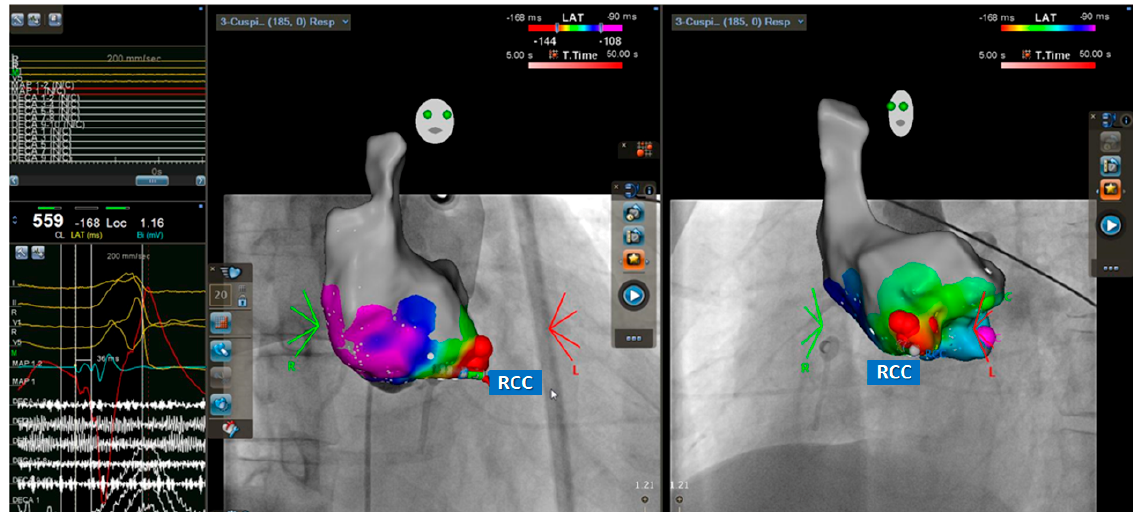
Figure 2. Activation map and fluoroscopic map for ventricular premature complex originating from the right coronary cusp (RCC). The local activation map showed the earliest activation site ( − 36 ms) at the RCC and catheter ablation in this area (red spots) could eliminate the ventricular arrhythmia.